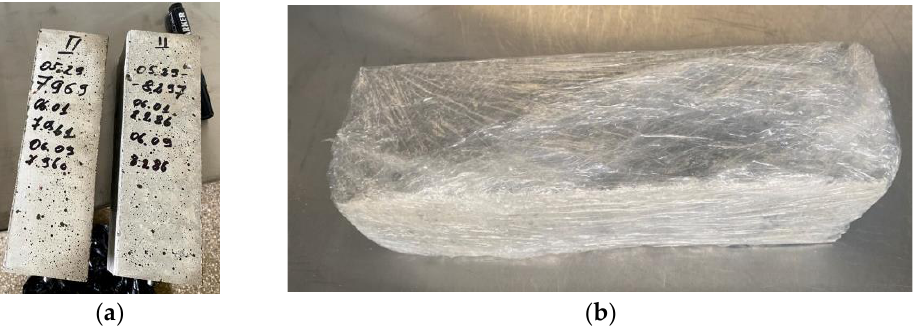
Figure 2. Formed concrete specimens: prisms of 75 mm × 75 mm × 250 mm during shrinkage measurement ( a ); same prism during storage period wrapped in the plastic film ( b ).